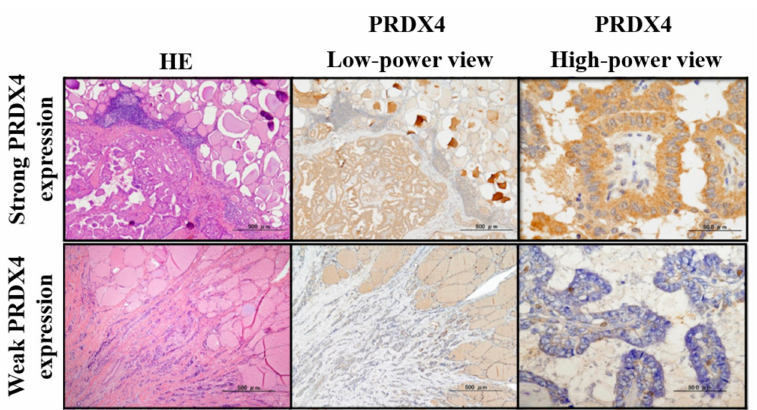
Figure 2. The immunohistochemical analysis of PRDX4 in PTC. Representative images of hematoxylin eosin (HE) staining (left) and the immunohistochemical analysis of PRDX4 (middle and right) in stage II-IV thyroid papillary carcinoma (strong PRDX4; weak PRDX4). Intracytoplasmic staining pattern of PRDX4 was confirmed in papillary thyroid carcinoma cells (left and middle: Bar = 500 µ m; right: Bar = 50 µ m).